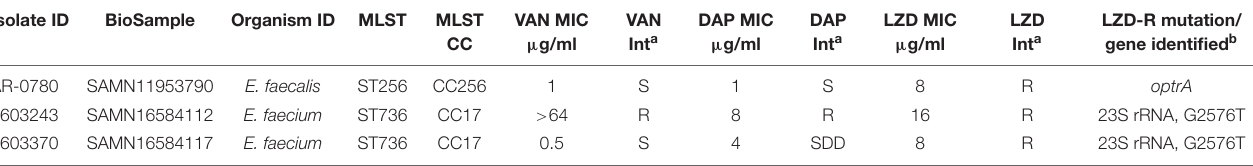
TABLE 2 | Characteristics of E. faecalis and E. faecium CDC Sentinel Surveillance isolates with linezolid resistance.